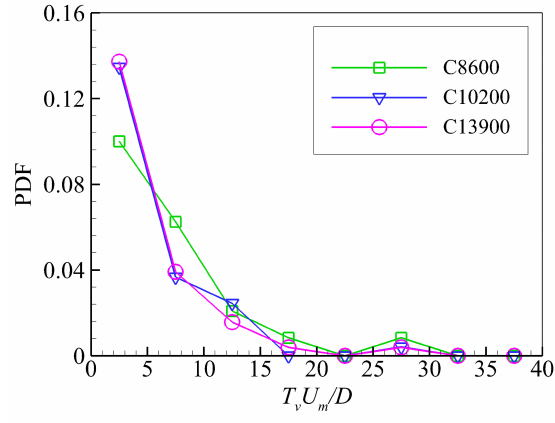
Figure 7. Probability density function (PDF) of the lifespan of